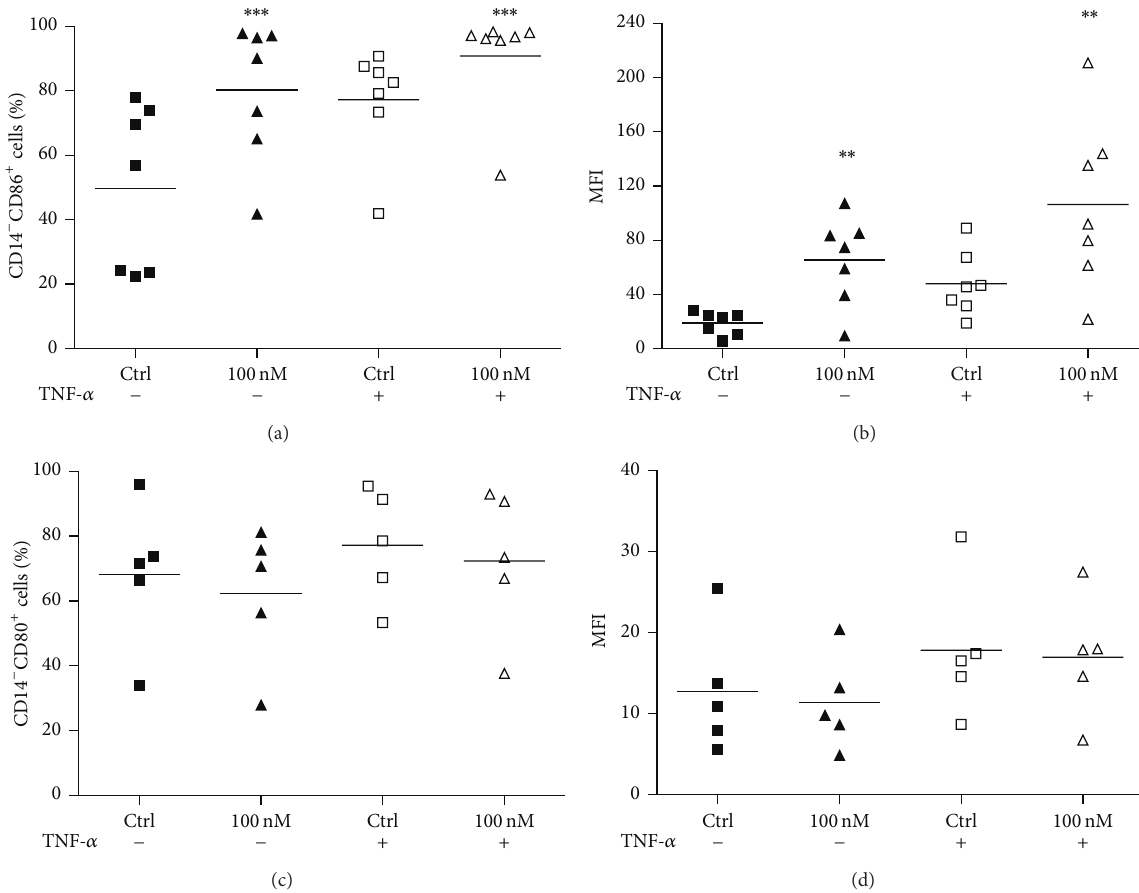
Figure 5: CD86 and CD80 expression on dendritic cells during activation. After the differentiation period (5 days), cells were incubated for further 48 h with or without TNF- 𝛼 (50ng/mL), in the presence or absence of 100 nM Oua. CD86 and CD80 expression was analyzed by flow cytometry. Data are expressed as (a, c) the percentage of positive cells, or (b, d) MFI (mean fluorescence intensity), and lines denote the means of five independent experiments. ∗∗ and ∗ ∗ ∗ are significantly different from the respective controls ( ∗∗ 𝑃 < 0.01 ; ∗∗∗ 𝑃 < 0.001